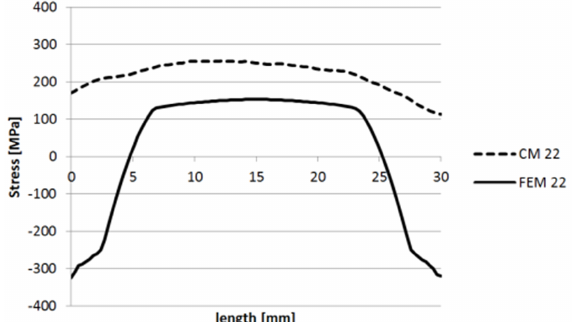
Figure 33. Stress levels in 11 direction along the CD line segment.